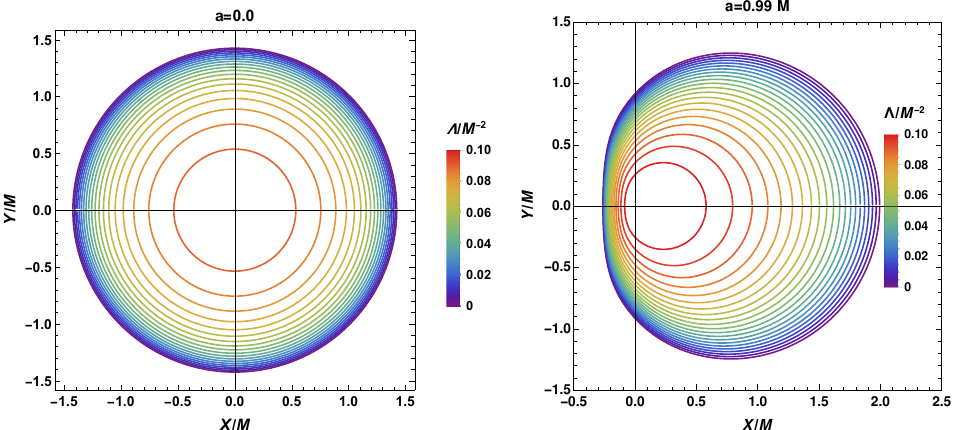
Figure 6. Shadow profile of Schwarzschild–de Sitter black holes ( left ) and new Kerr–de Sitter black holes ( right ) with a varying Λ compared with Kerr black hole (outermost solid curve corresponding to Λ →